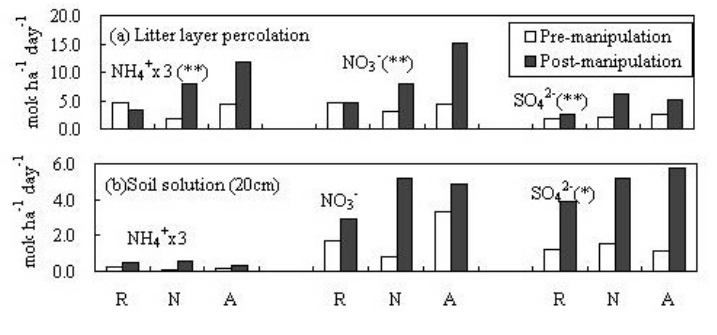
FIGURE 4 . The effects of N manipulation to the daily ion flux from (a) litter layer and (b) soil solution (20-cm depth) in Kannondai. Confidende limit: 99% (**), 90% (*), R: removal, N: no manipulation, A: addition .